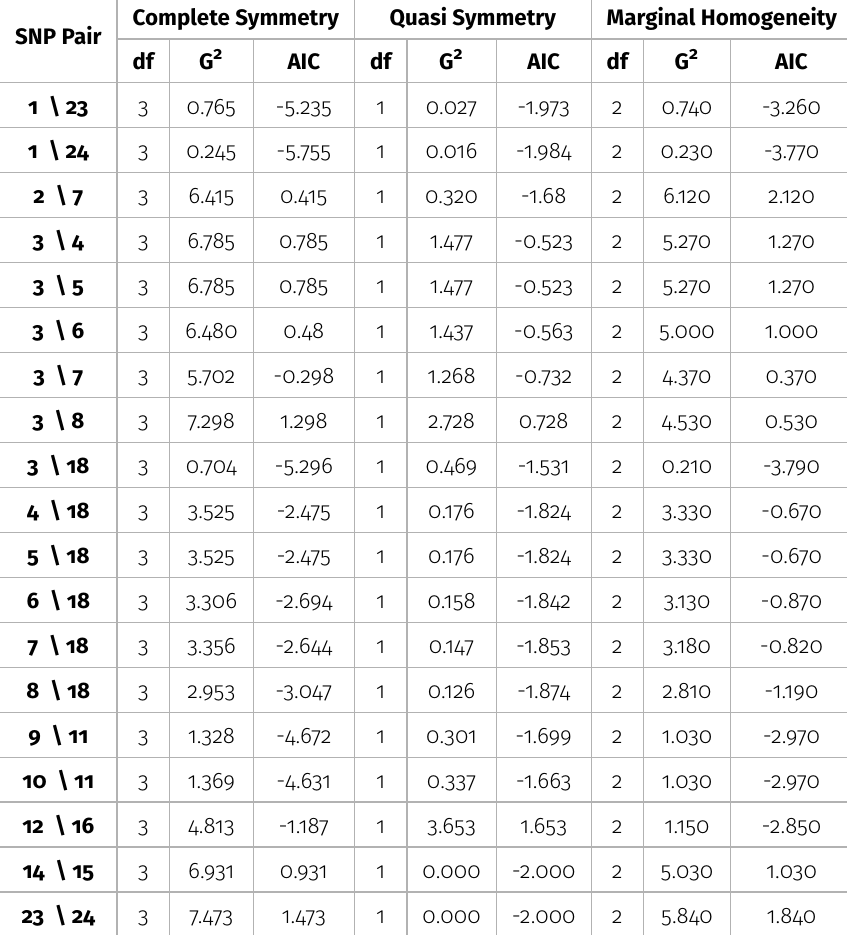
Table V. Model comparison